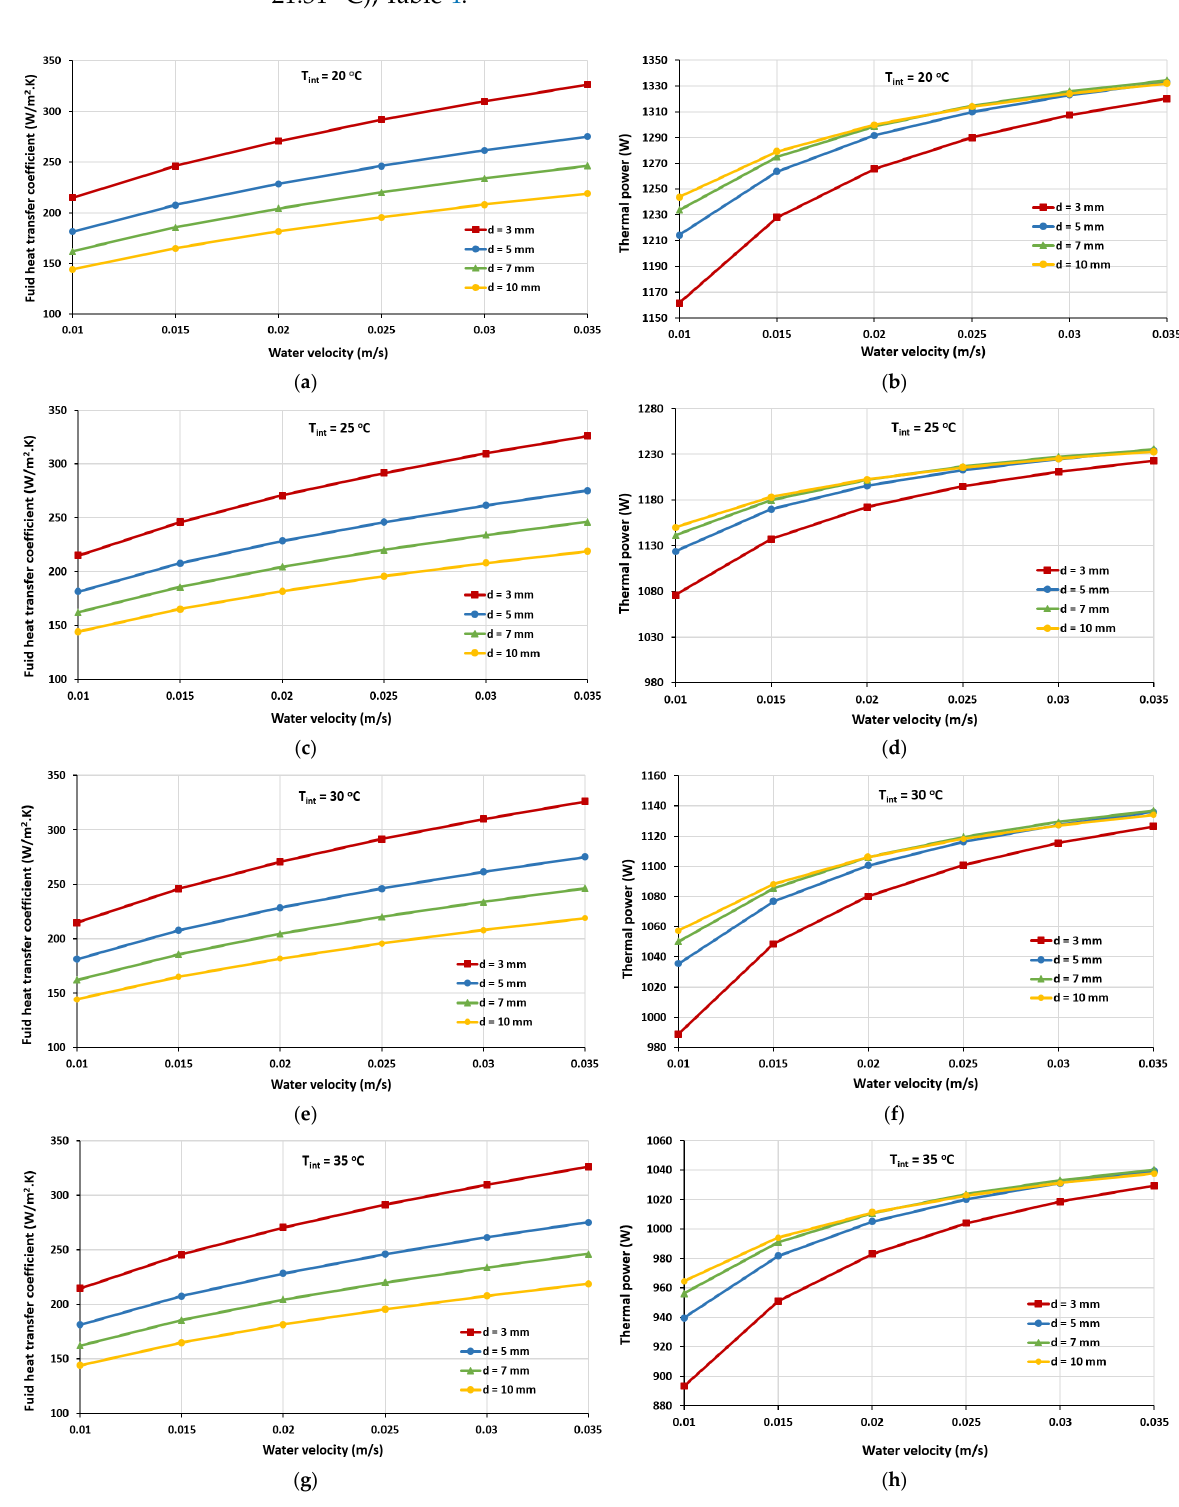
Figure 6. Effect of water thickness on fluid transfer coefficient and thermal power for different inlet temperatures: ( a , b ) T int = 20 °C; ( c , d ) T int = 25 °C; ( e , f ) T int = 30 °C; ( g , h ) T int = 35 °C.